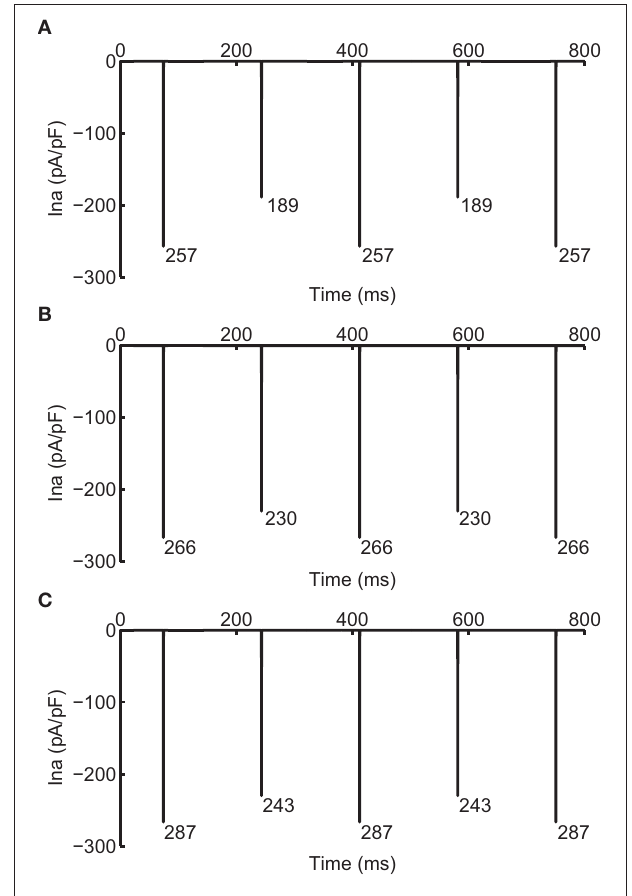
FIGURE 5 | I Na during normal (A) and supernormal (B,C) conduction. (B) shows I Na when j gate was set equal to 1 and (C) shows that when the computed I Na was increased for all beats by 23%, i.e., computed I Na was scaled by 1.23. All currents are shown at CL of 169ms. The number below each negative peak indicates the peak I Na value for that